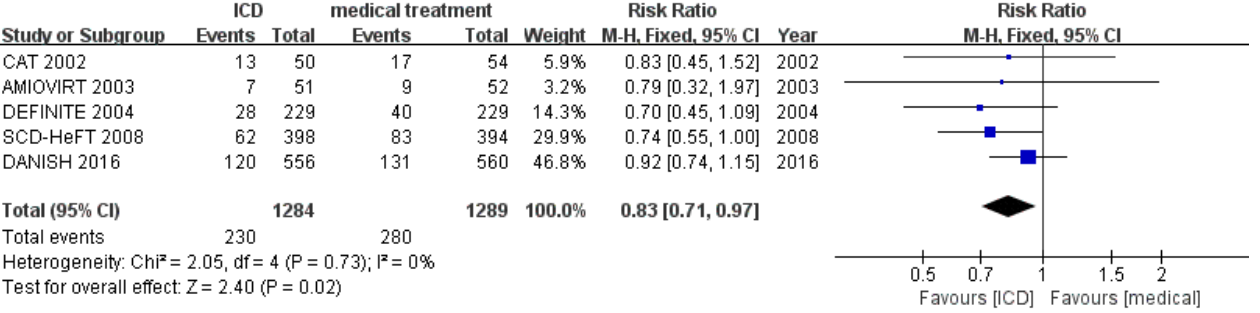
Fig. 3 - All-cause mortality among patients with non-ischemic heart disease randomized to implantable cardioverter -defibrillator (ICD) vs. medical treatment only in primary